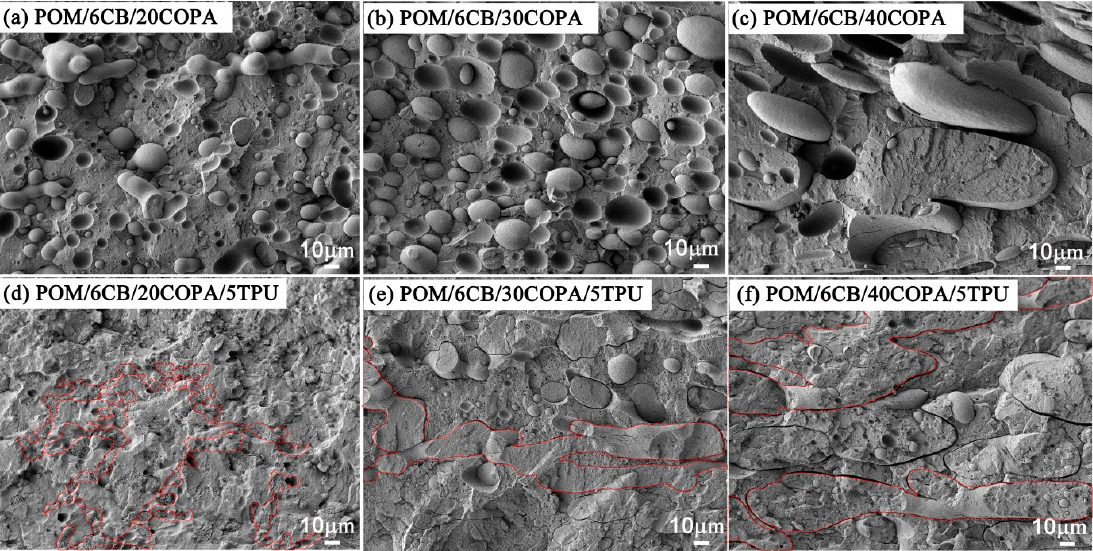
Figure 5. FESEM micrographs of ( a ) POM/6CB/20COPA; ( b ) POM/6CB/30COPA; ( c ) POM/6CB/40COPA; ( d ) POM/6CB/20COPA/5TPU; ( e ) POM/6CB/30COPA/5TPU; and (f) POM/6CB/40COPA/5TPU composites. The TPU phase was etched by DMF.